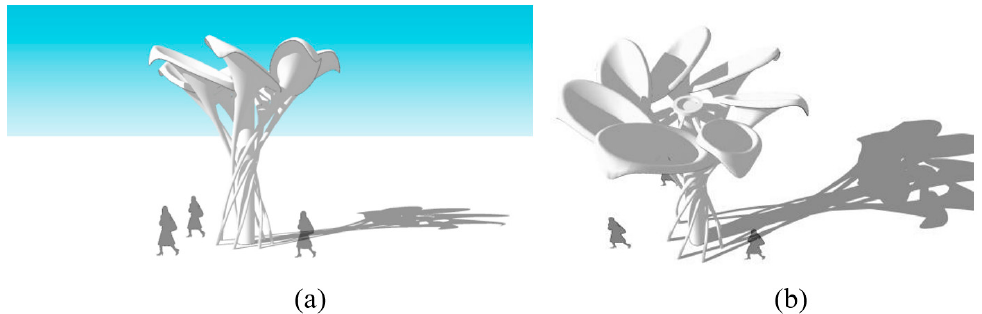
Figure 20. The analysis of product modeling structure characteristics: ( a ) front view, and ( b ) top view. Colour Material